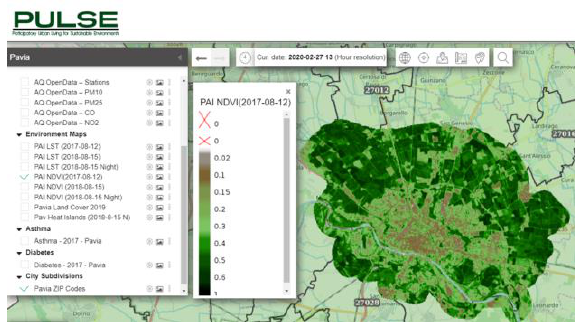
Figure 4. NDVI map for Pavia; green pixels have a high NDVI value and correspond to fields or gardens; grey areas have a low NDVI value and correspond to built-up